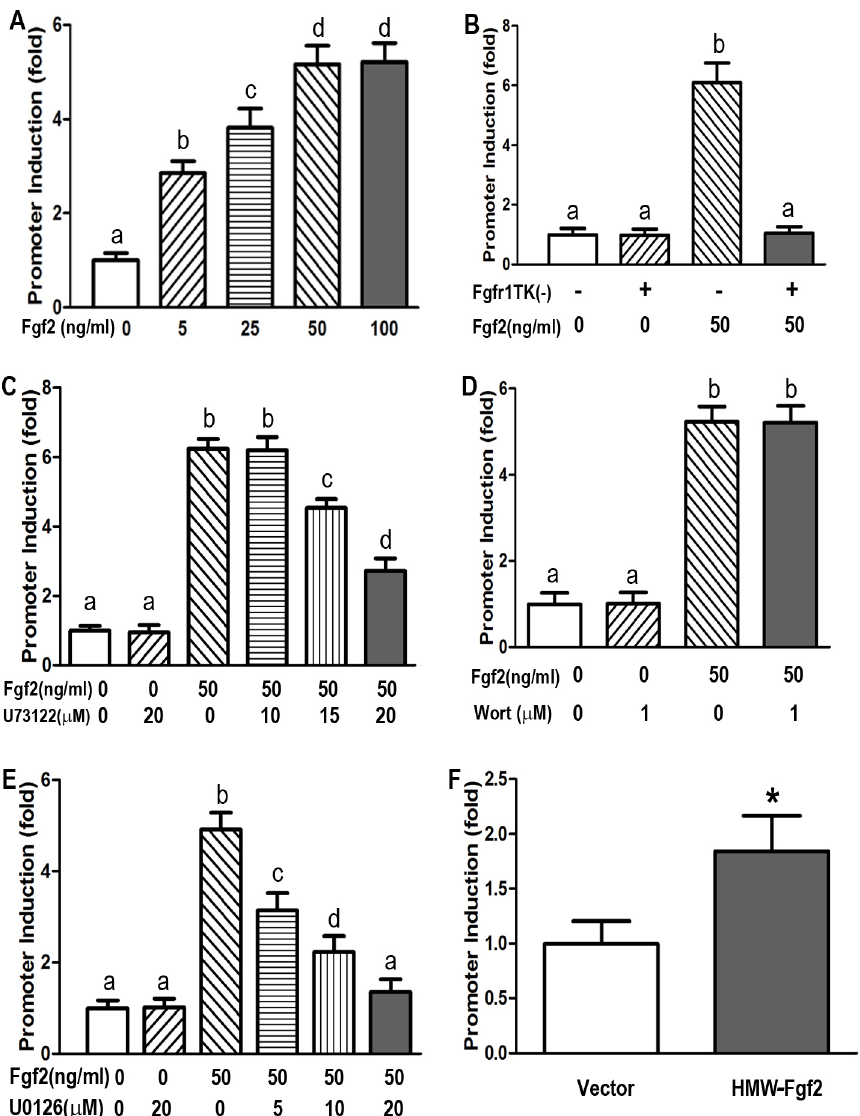
Figure 5. Enhancement of mouse FGF23 promoter activity by FGF2 via FGFR1 signaling pathway. MC3T3-E1 cells were co-transfected with various plasmids and treated with different drugs as described in Material and Methods. (A) Dose-dependent stimulation of mouse FGF23 promoter activity by recombinant FGF2 (5 , 100 ng/ml); (B) Dominate-negative FGFR1(TK 2 ) constructs blocked the stimulatory effect of recombinant FGF2 (50 ng/ml) on mouse FGF23 promoter activity; (C) Effect of PLC c inhibitor (U73122) on FGF2-induced FGF23 promoter activity; (D) Effect of PI3K inhibitor Wortmannin (Wort) on FGF2-induced FGF23 promoter activity; (E) Dose-dependent inhibition of FGF2-induced FGF23 promoter activation by MAPK inhibitors (U0126). (F) Overexpression of HMW- Fgf2 constructs stimulated mouse FGF23 promoter activity. Data are expressed as the mean 6 S.D. from triple three independent experiments. Values sharing the same superscript in different groups are not significantly different at P , 0.05. * indicates significant difference from control vector group.